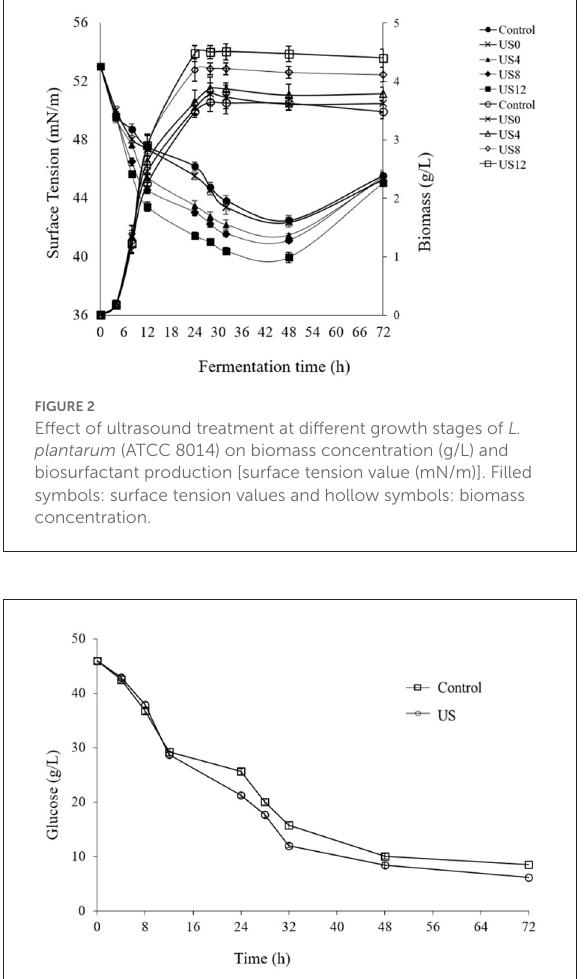
biosurfactant production affected by ultrasonication at the 12th h of the fermentation process significantly reduced the surface tension value (39.95 ± 0.35 mN/m) compared to the control (42.49 ± 0.34 mN/m) and samples sonicated at 0th (42.35 ± 0.3 mN/m), 4th (41.46 ± 0.14 mN/m), and 8th (41.10 ± 0.02 mN/m) h of the process after 48